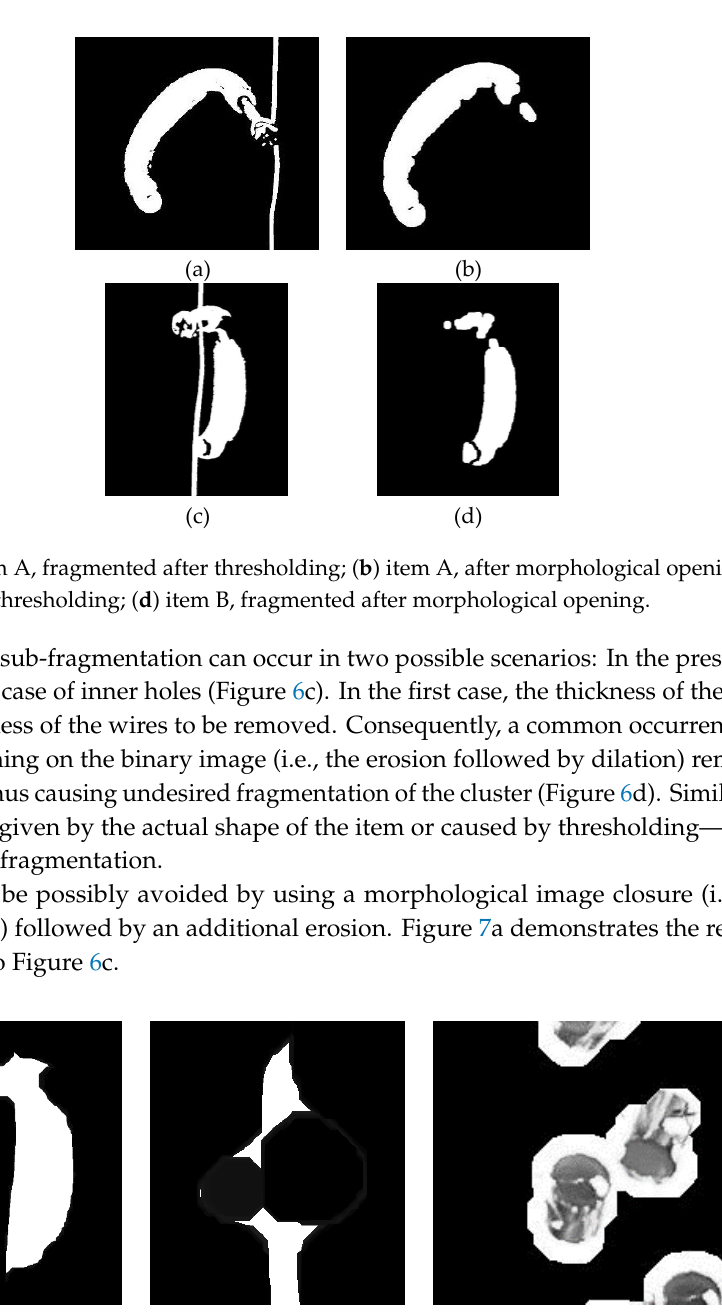
Figure 7. ( a ) Item B after morphological image closing plus image erosion; ( b ) an example of wires loop after morphological closing followed by image erosion; ( c ) clusters merged after dilation. The image is intentionally left in grayscale to show actual original items.